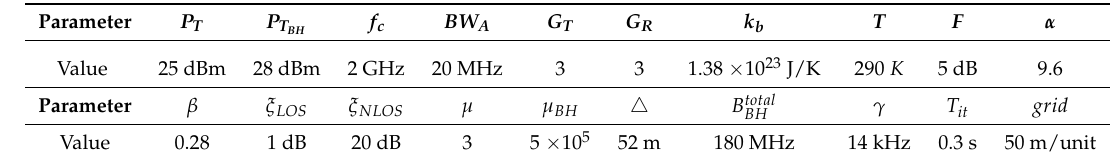
Table 1. General parameters for the communications field.